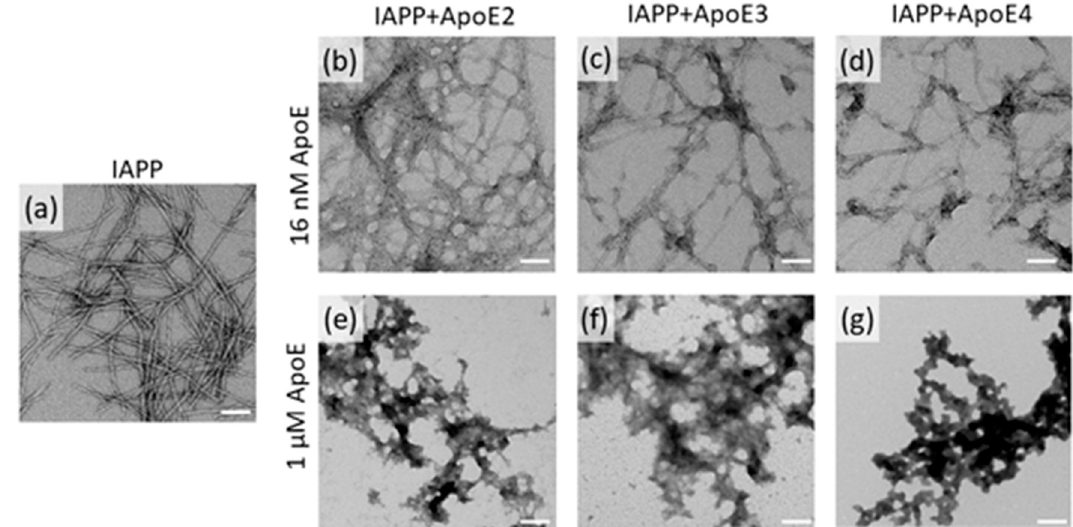
Figure 2. TEM images of IAPP samples incubated in the presence or absence of ApoE. Fibrils produced from 5 µM IAPP alone ( a ); from IAPP in the presence of 16 nM ApoE2, ApoE3, and ApoE4 ( b , c , d ); and from IAPP in the presence of 1 µM ApoE2, ApoE3, and ApoE4 ( e , f , g ). The scale bar is 100 nm. Larger fields of the images are shown in Figure S3 .